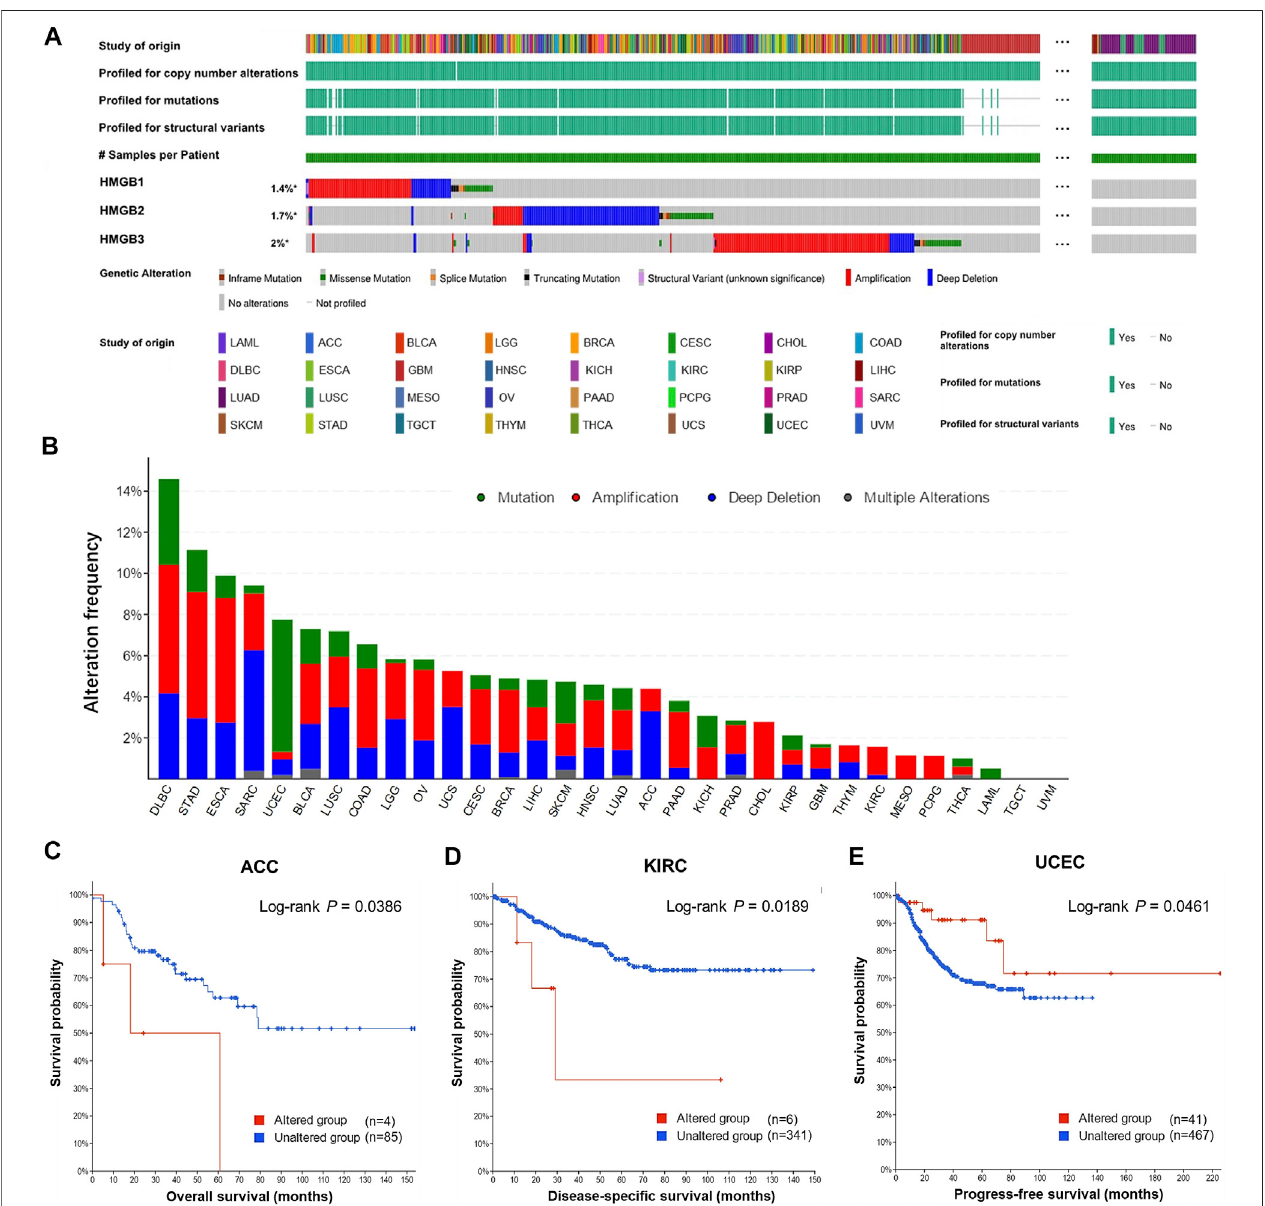
FIGURE 4 | Genetic alternations of High Mobility Group Box (HMGBs) in cancers. (A) An overview of the genomic alternations of HMGBs occurred in pan-cancer. (B) The alternation frequency of HMGBs in cancers. Associations of HMGBs ’ global alternation with the survival of patients with (C) ACC, (D) KIRC, and (E) UCEC